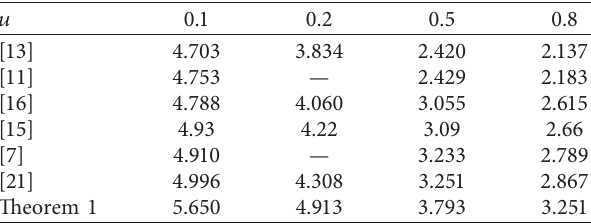
Table 2: Upper bound of h for Example 2 with different u